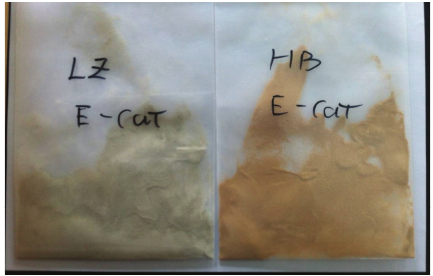
Figure 6: Color of E-catalysts with varying iron